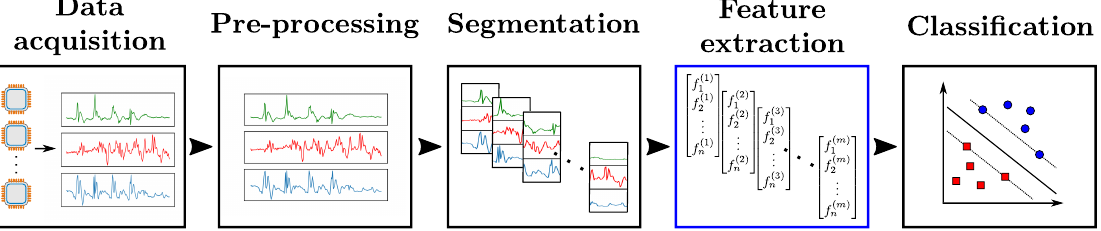
Figure 1. Activity Recognition Chain (ARC). Raw data are firstly acquired from sensors. After pre-processing, segments of data are extracted (Segmentation) and values relevant to the recognition problem are computed from them (Feature extraction). A classifier is then trained and evaluated using those features (Classification). In our framework, all steps of the ARC—except the feature extraction part—are fixed, and a Support-Vector-Machine (SVM) classifier is used for the classification